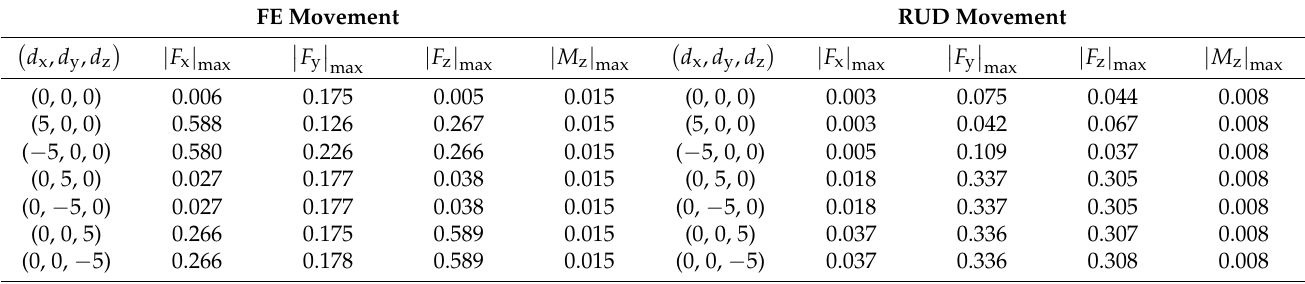
Figure 10. Relation between parasitic motions of the 3-RPS robot and the force/torque of the joints 1–4 for RUD movement. Table 4. Maximum force and torque under different initial offset conditions.